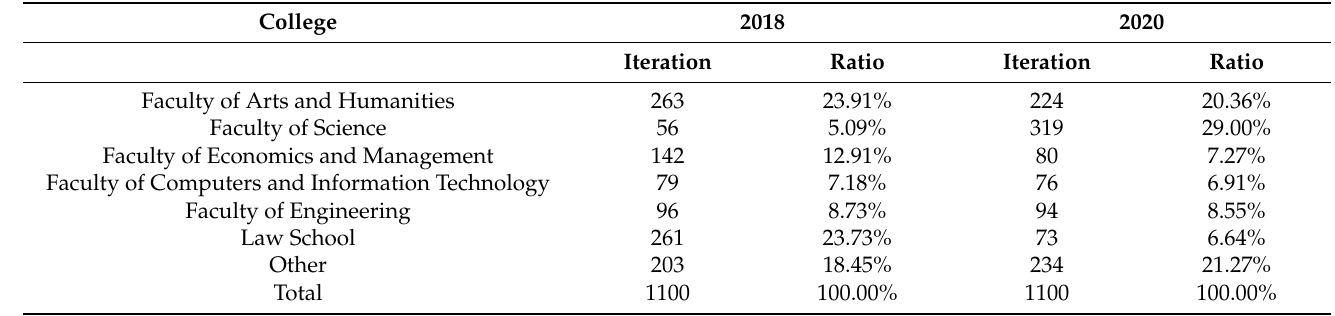
Table 4. Distribution of student numbers by the college between 2018 and 2020 survey